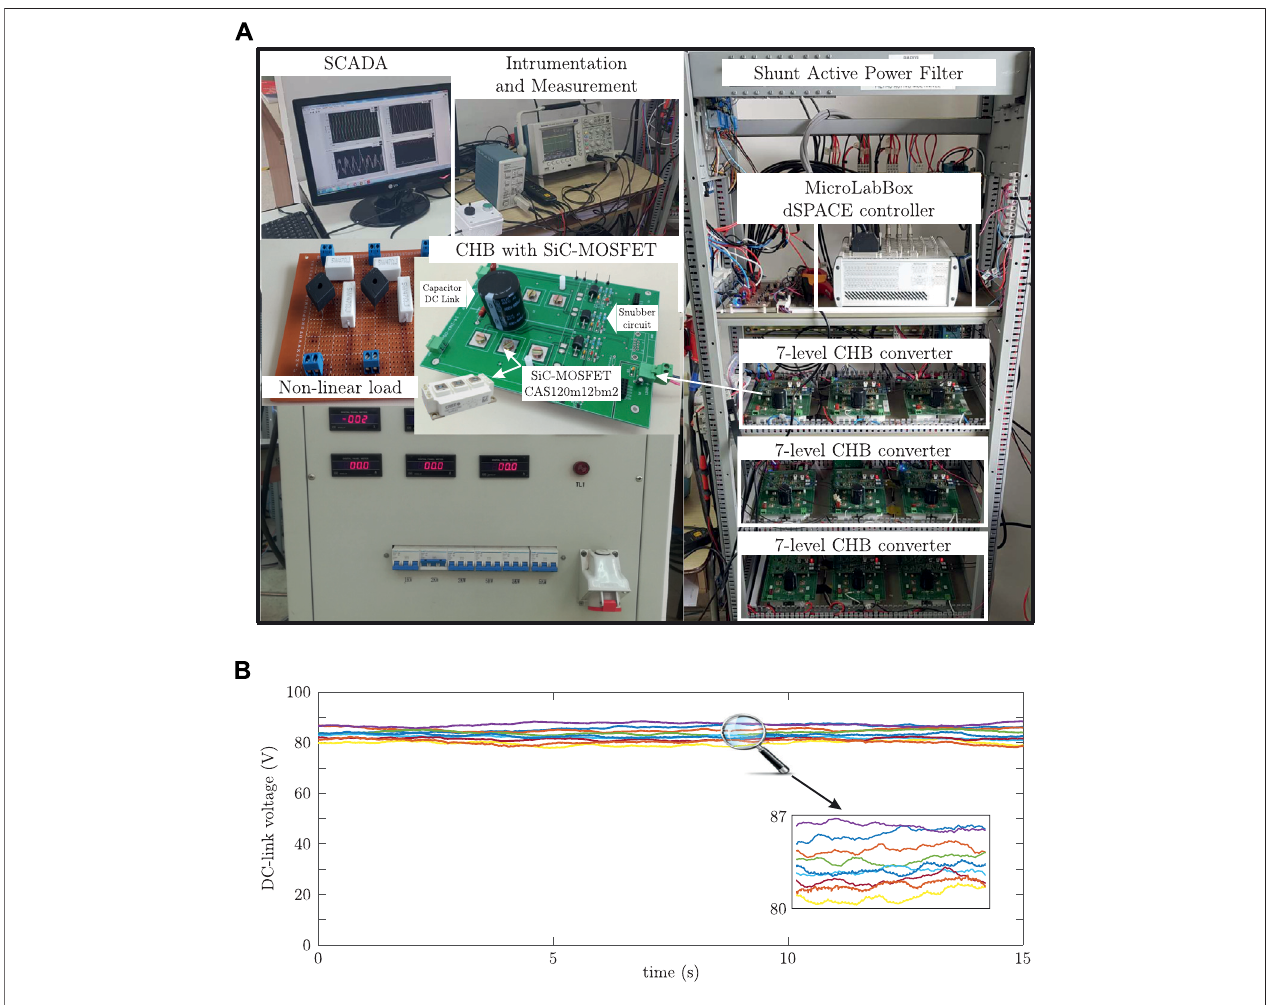
FIGURE 2 | (A) Picture of the experimental test bench. (B) DC-link voltage